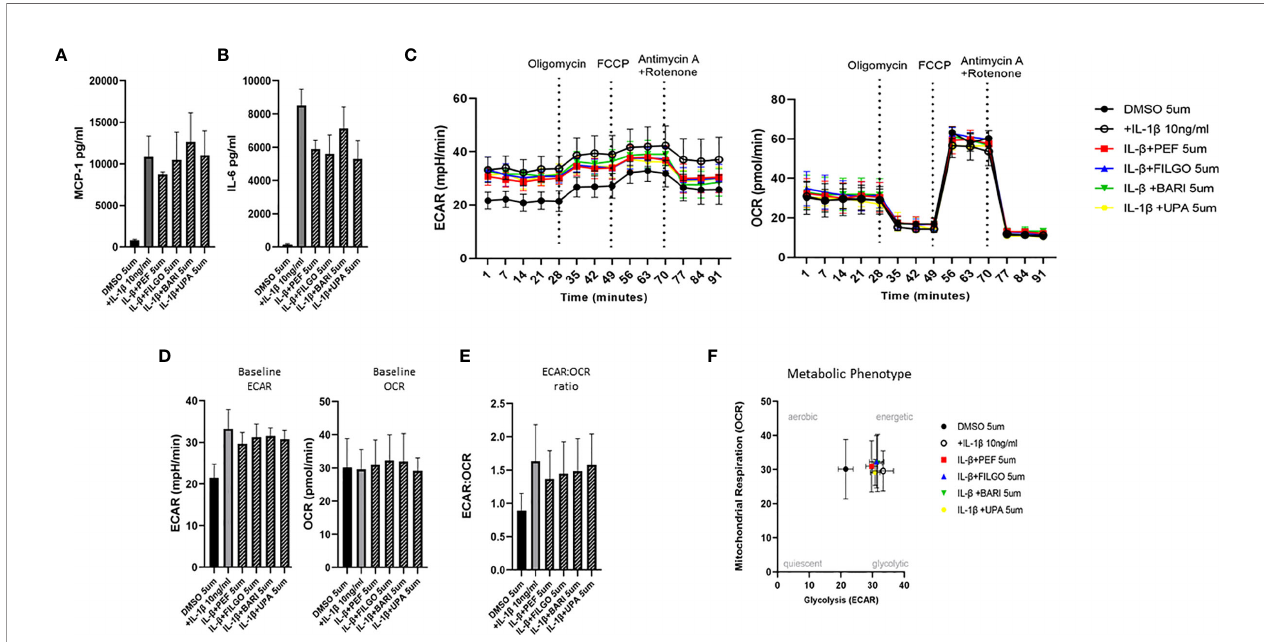
FIGURE 3 | Effect of JAKi on the IL-1 b -induced expression of pro-in fl ammatory mediators and bioenergetic pro fi le in PsAFLS. (A, B) PsAFLS were treated with JAKi (5 µM) or DMSO (5 µM) for 1 h and stimulated with IL-1 b (10 ng/ml) for 24 h. Bar graphs demonstrating secretion of (A) MCP-1 and (B) IL-6 by ELISA (n = 3). (C) Average seahorse pro fi les demonstrating extracellular acidi fi cation rate (ECAR) (glycolysis) and oxygen consumption rate (OCR) (oxidative phosphorylation). (D) Representative bar graphs demonstrating baseline ECAR and OCR and (E) ECAR : OCR ratio. (F) Metabolic phenotype pro fi le in PsAFLS, n = 3. Values expressed as mean +/-